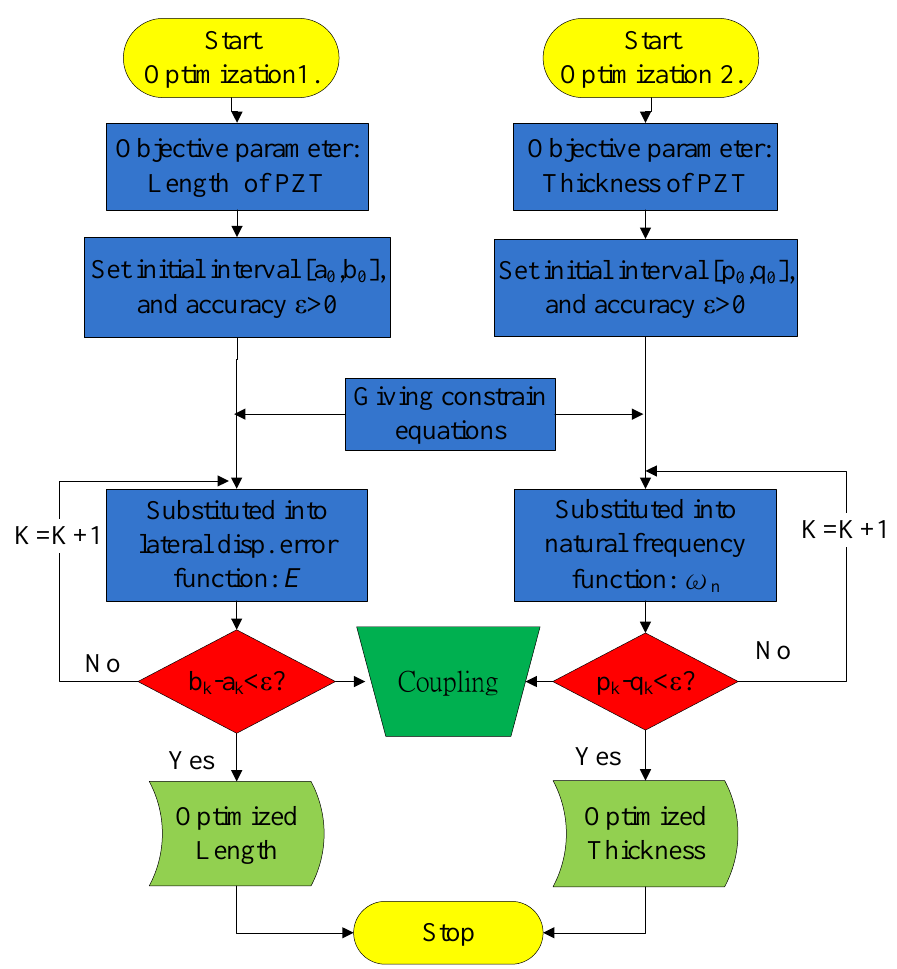
Figure 7. Flowchart of the PZT optimization procedure.